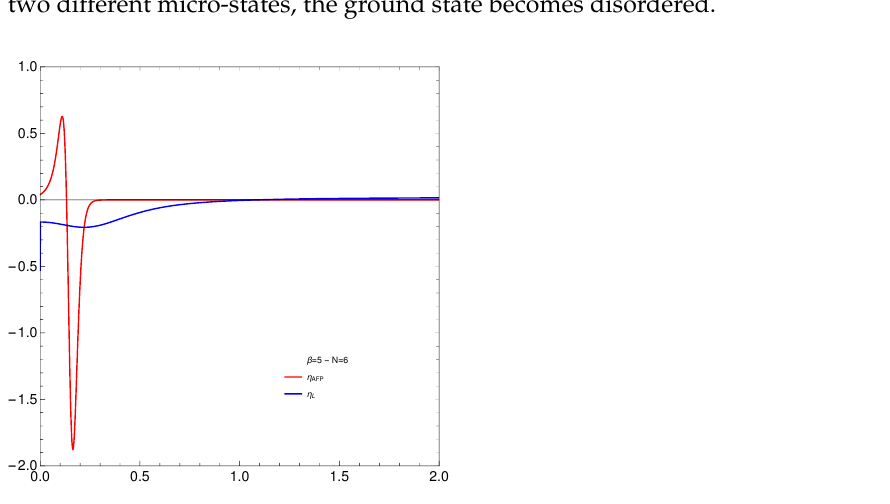
Figure 1. η AFP (red) and Lipkin’s η L (blue) vs. v , for N = 6 and the low temperature β = 5. Note that η AFP (red) clearly detects a phase transition. There is none for the Lipkin model.